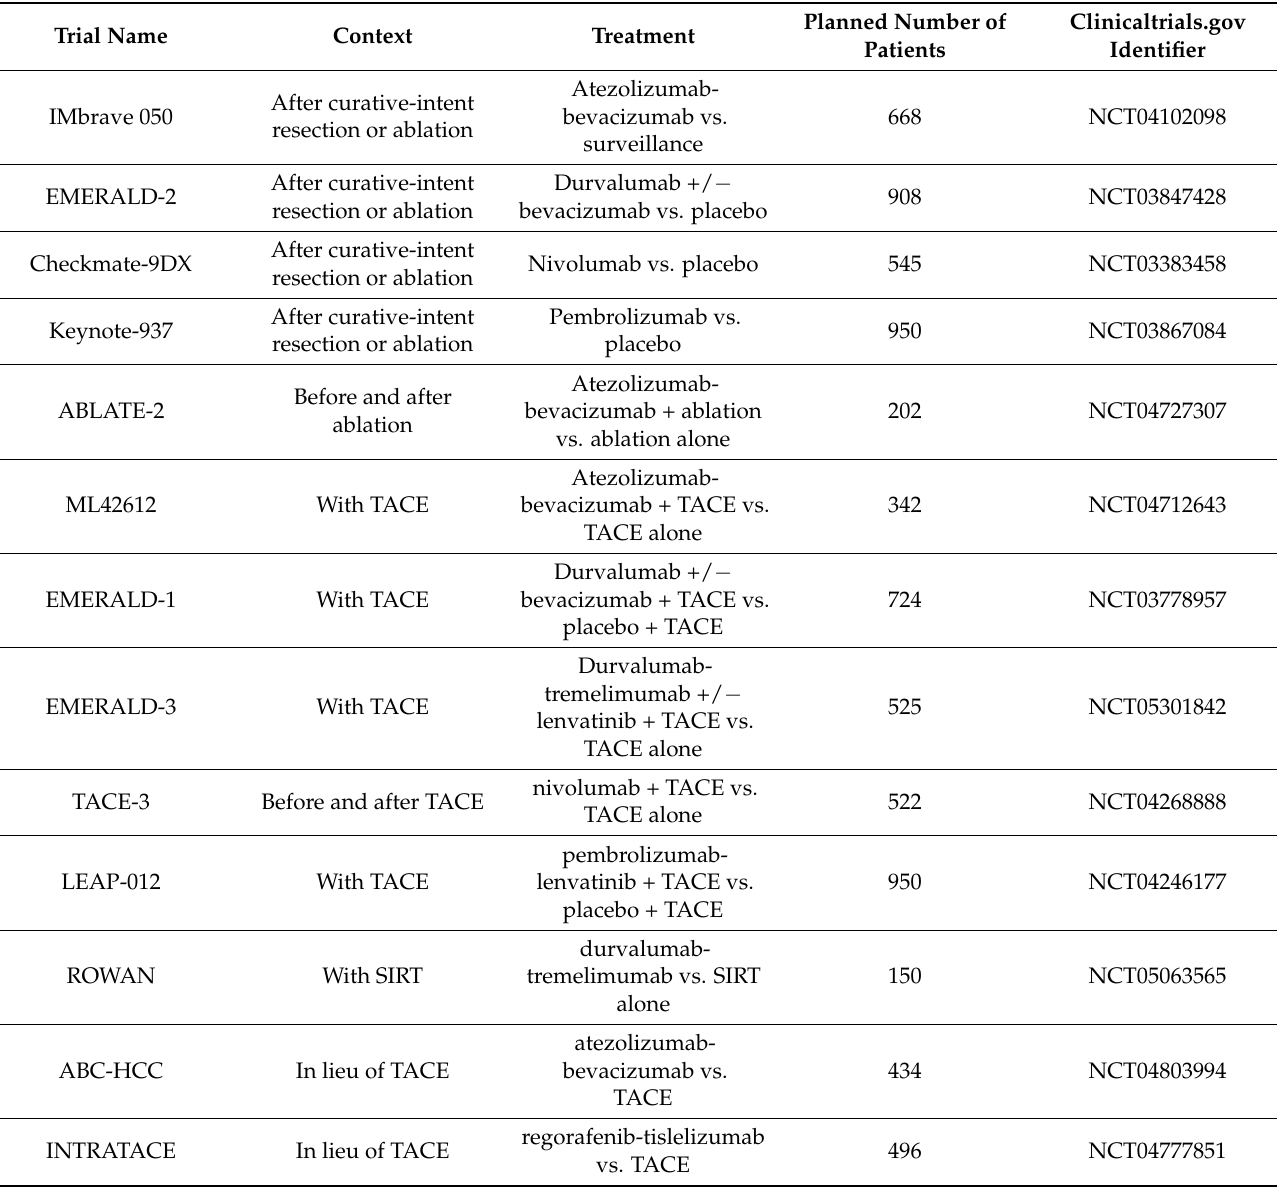
Table 4. Ongoing randomized trials testing immunotherapy in earlier stages of HCC. TACE: Trans- arterial Chemoembolization; SIRT: Selective Internal Radiation